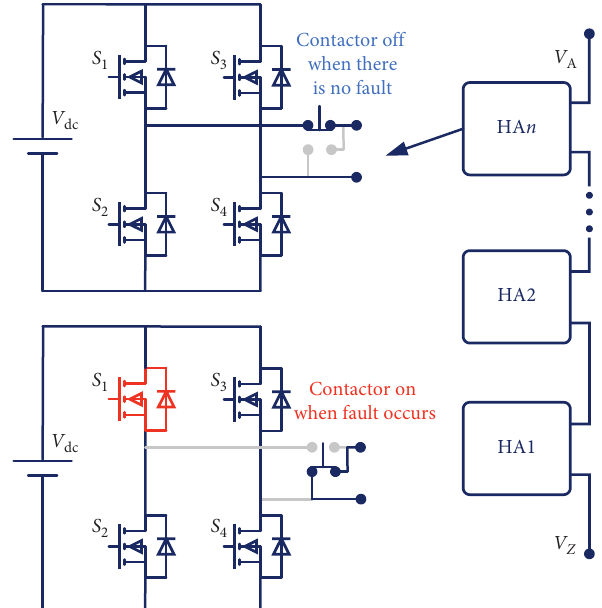
Figure 4: Output contactor of